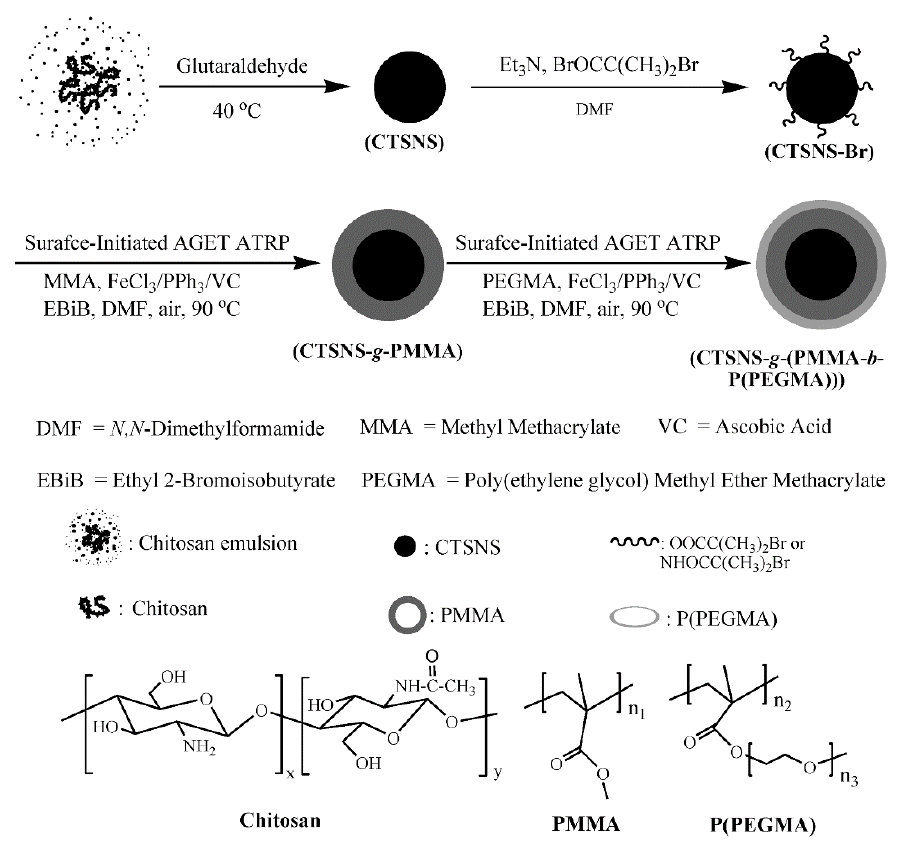
Figure 7. Modification of chitosan nanospheres (CTSNSs) by SI-AGET ATRP mediated by